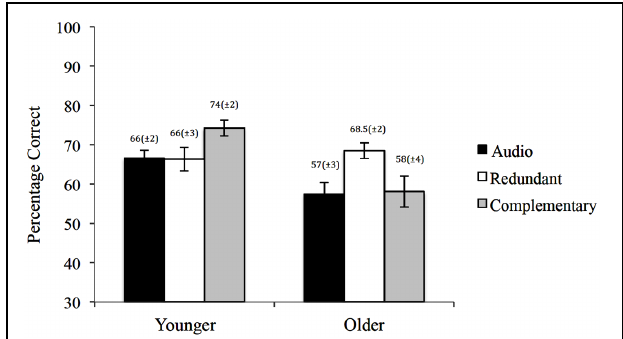
FIGURE 1 | Differences in comprehension performance between presentation conditions for both younger and older adults (bars represent